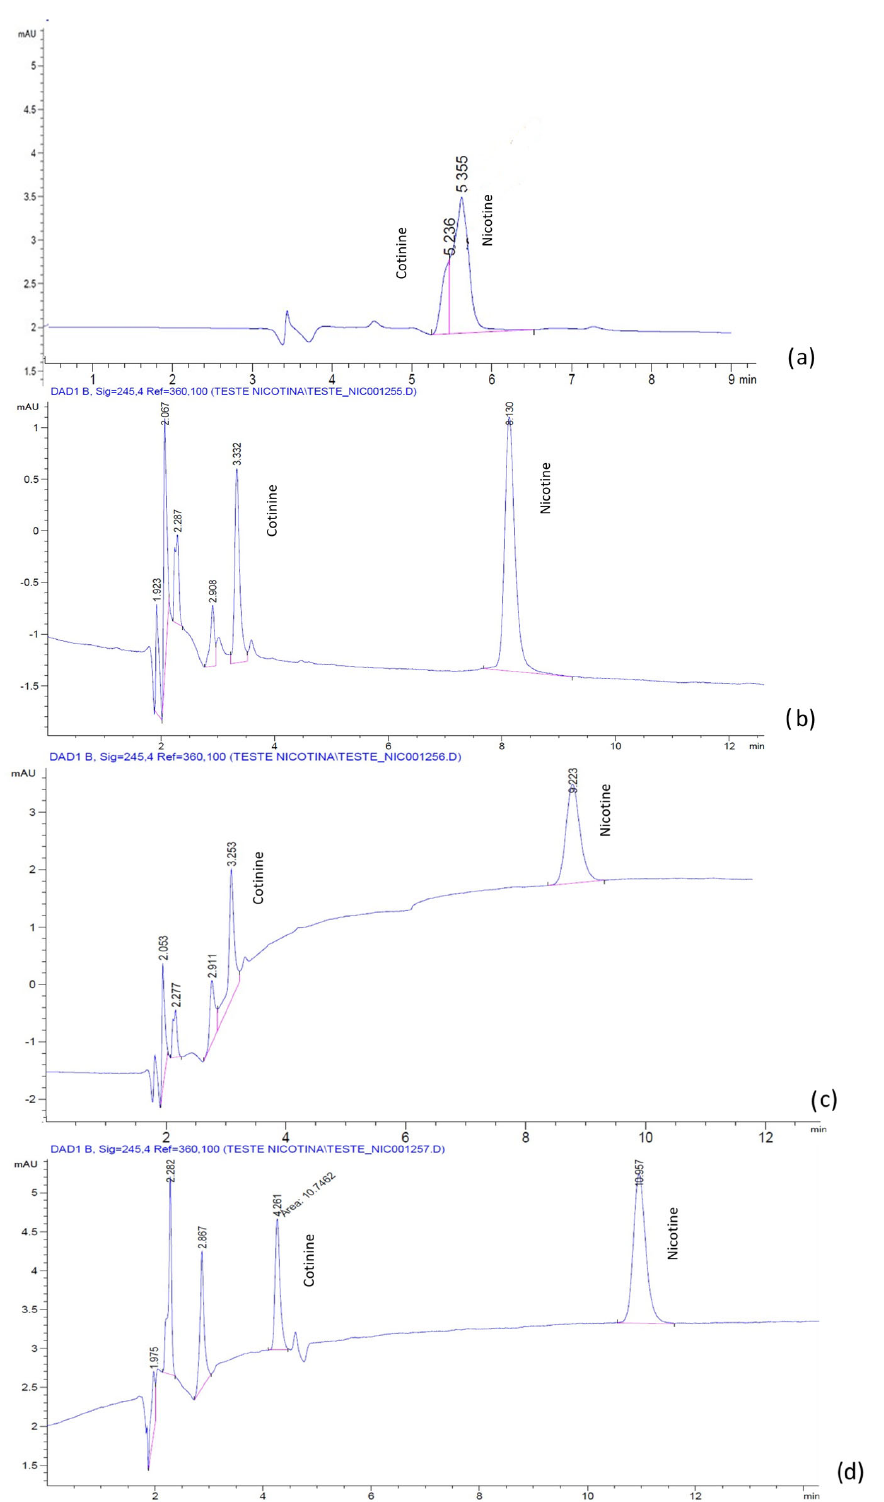
Figure 4. Chromatograms of nicotine and cotinine in human plasma with mobile phases containing phosphate buffer:ACN 60:40 (pH 2.3 with H 3 PO 4 ): ( a ) without additive; ( b ) with 0.5 mM BMIM[PF 6 ]; ( c ) with 1.0 mM BMIM[PF 6 ]; ( d ) with 2.5 mM BMIM[PF 6 ] .